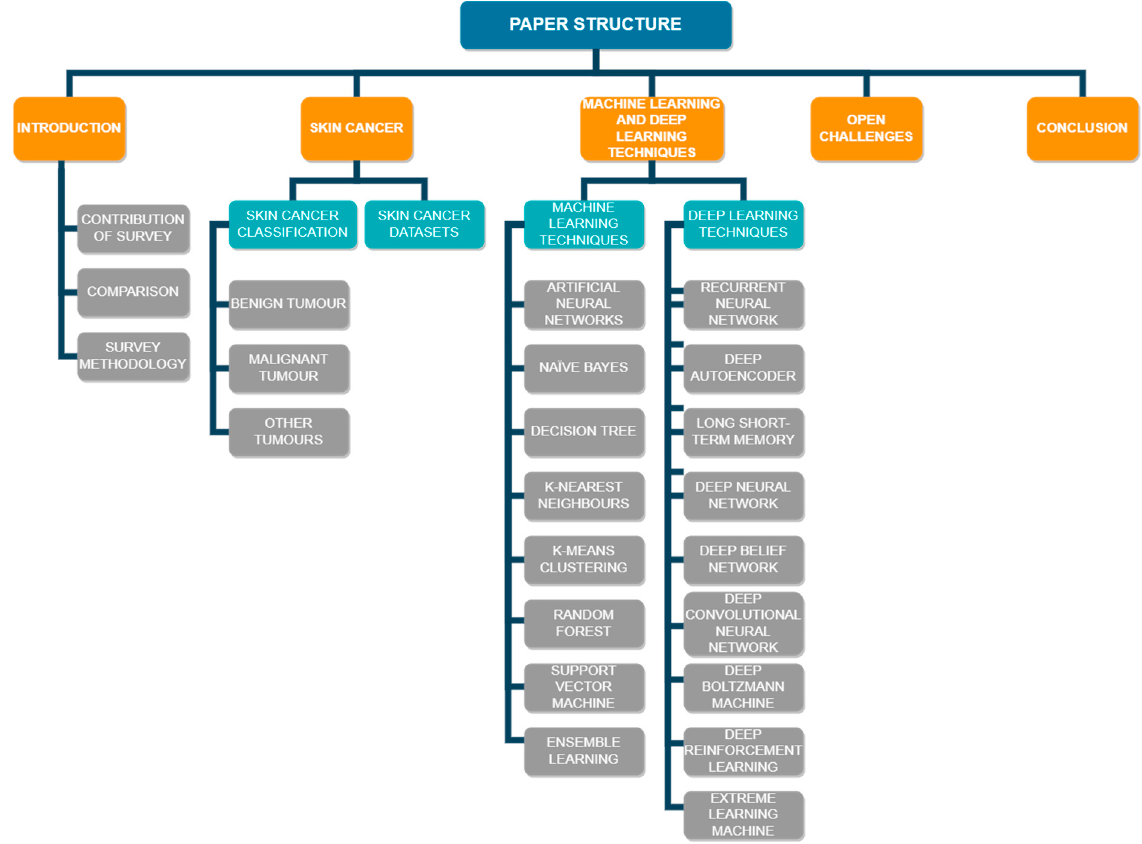
Figure 4. Structure of this review.